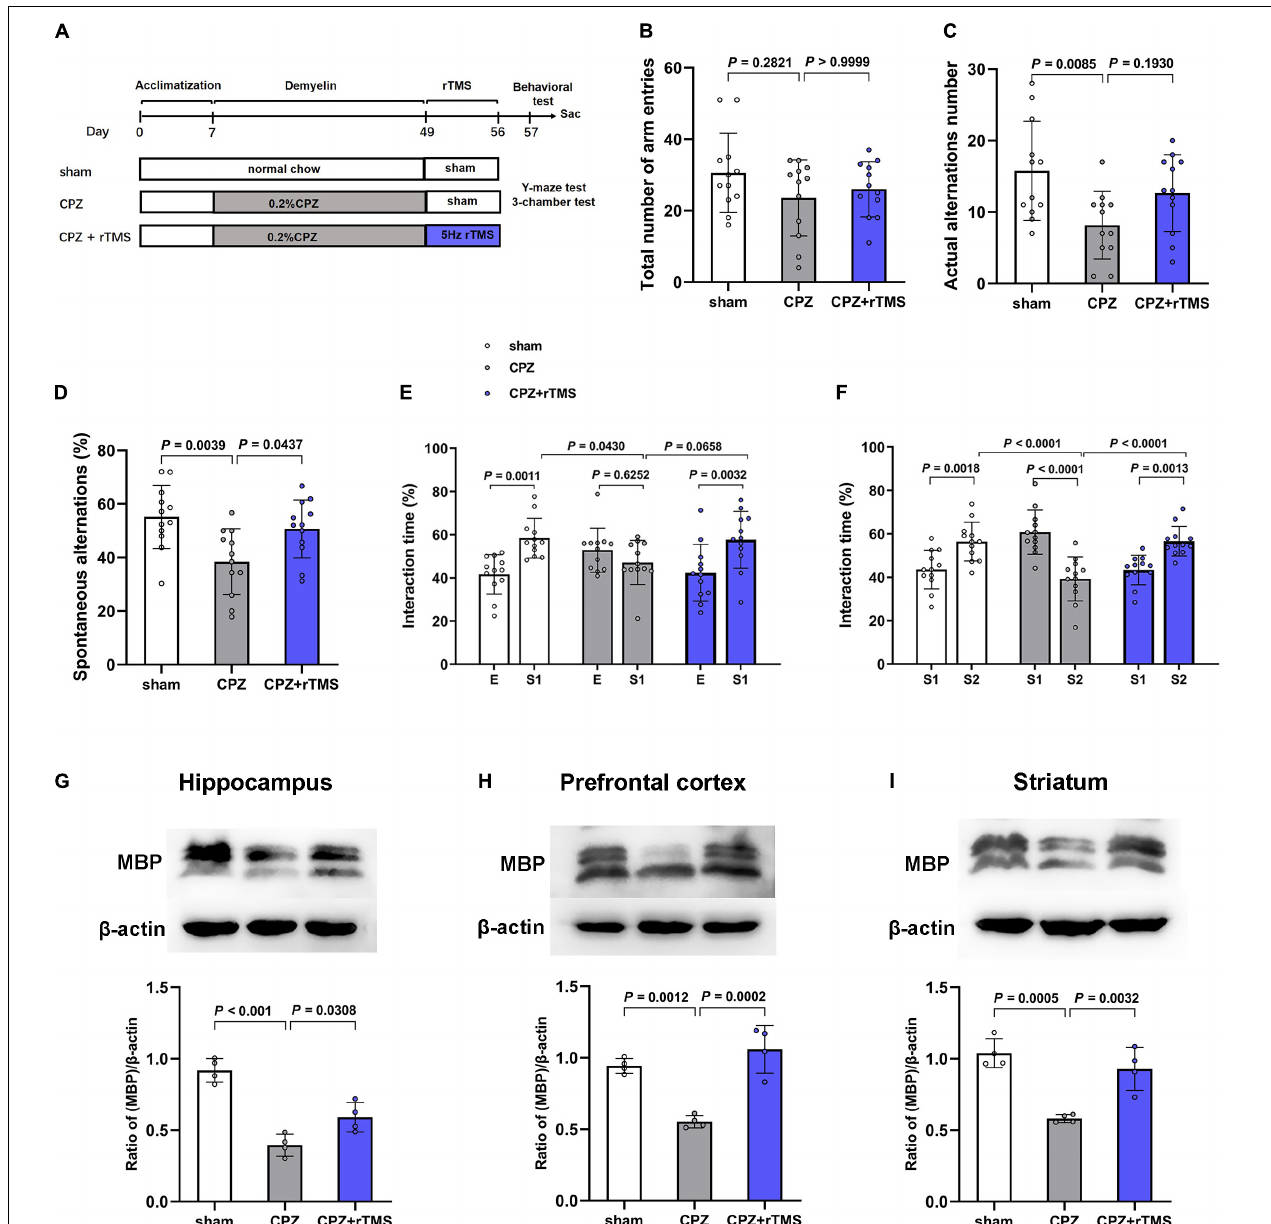
FIGURE 1 | rTMS ameliorated CPZ-induced cognitive impairment and demyelination in mice. (A) Schematic diagram displaying the time course of rTMS treatment in a CPZ-induced mouse model of demyelination. C57BL/6 mice were administered CPZ for 6 weeks to induce demyelination, and rTMS was administered for 1 week after the conclusion of CPZ administration. (B–D) In the Y-maze test, CPZ-treated mice showed impaired spatial working memory and spatial cognitive ability, which was restored by rTMS. (E,F) In the 3-chamber test, mice in the CPZ group showed reduced social interactions and weaker social memory. Mice in the CPZ + rTMS group performed better than those treated with CPZ alone. (G–I) Representative immunoblots and densitometry analysis of MBP in the hippocampus, PFC, and striatum in the sham, CPZ, and CPZ + rTMS groups. E, empty wire-cup; S1, subject 1; S2, subject